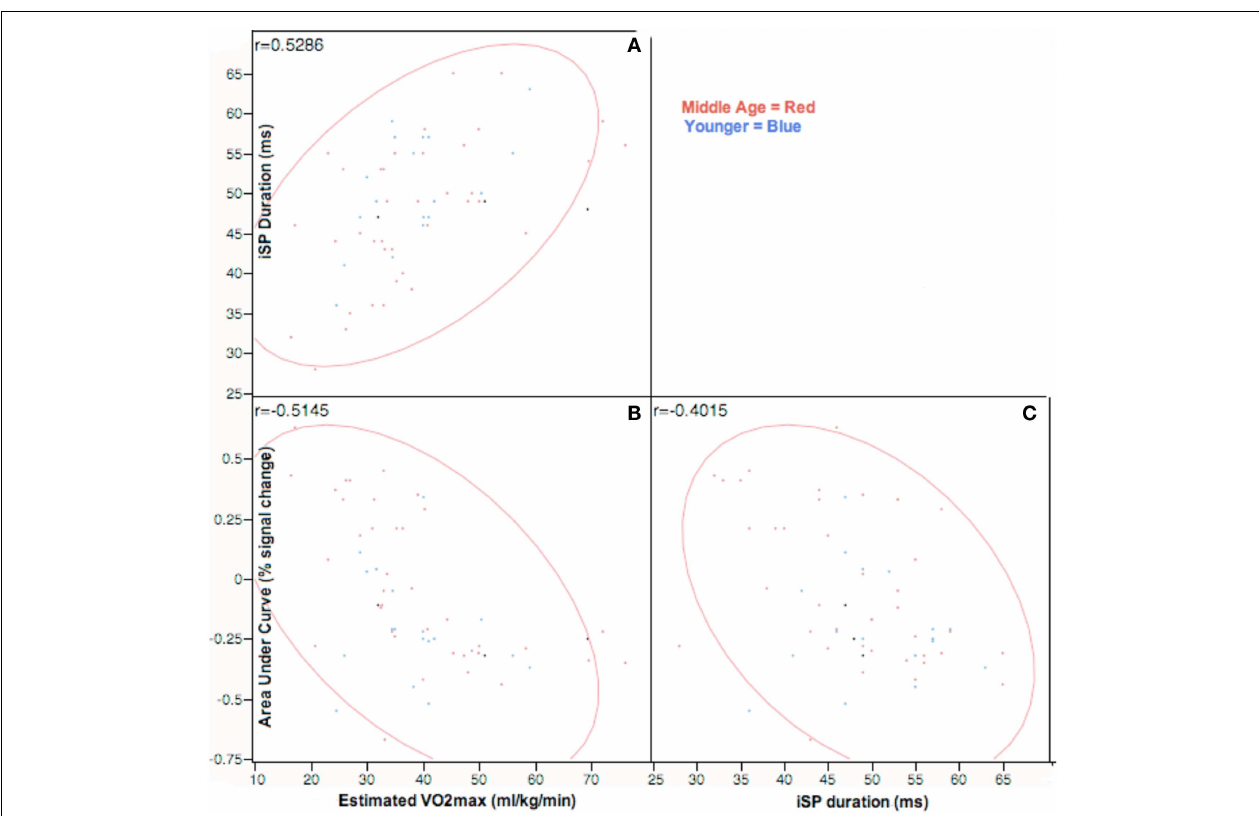
rM1S1 . Right M1S1 AUC values are negatively correlated to duration of ipsilateral silent period. Correlations are represented in the top left corner for comparisons of: (A) iSP duration and estimatedVO 2 max; (B) fMRI AUC of right M1S1 andVO 2 max; (C) iSP duration and fMRI AUC of right M1S1.